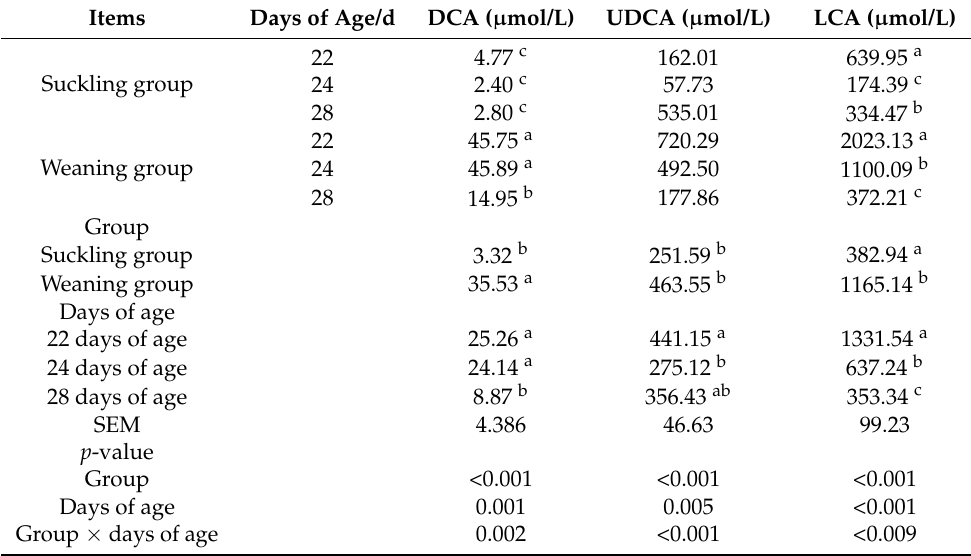
Table 3. Effects of weaning at 21 days of age on secondary BAs of cecum